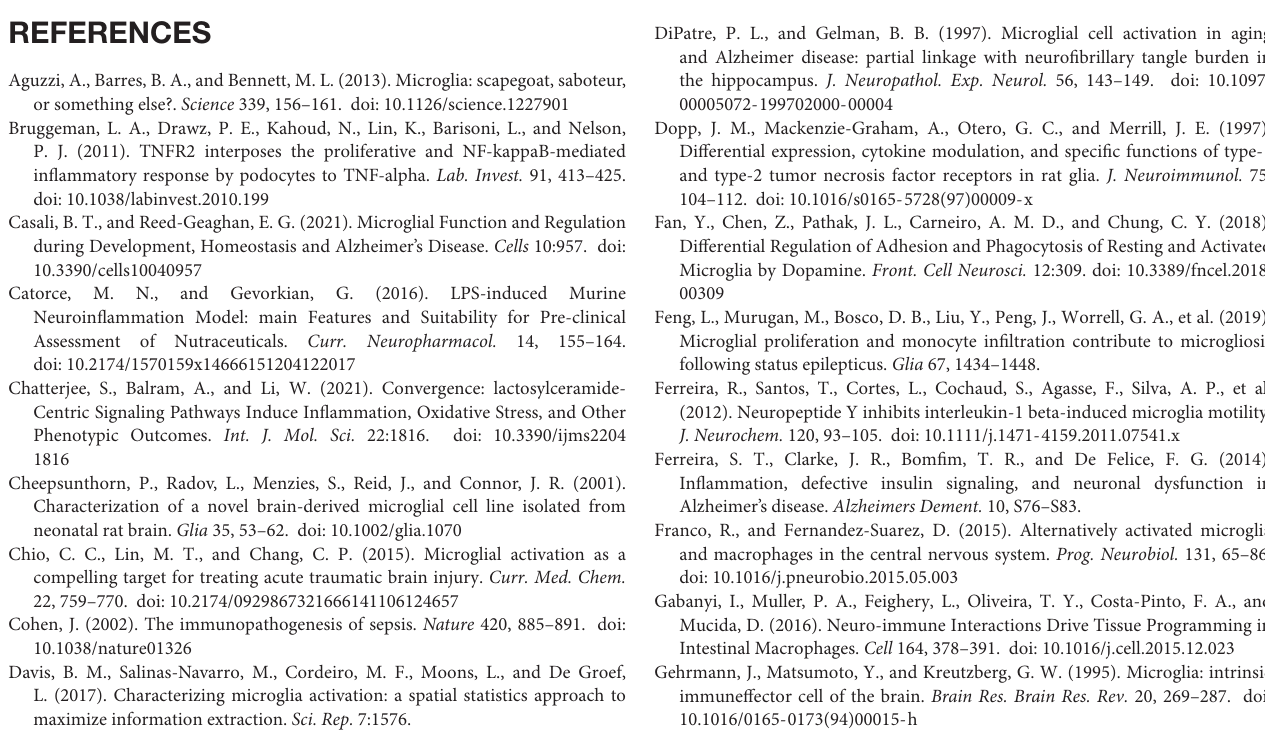
Supplementary Figure 1 | Expression of β -1,4-galactosyltransferase V ( β -1, 4-GalT V) in primary cultured microglia. Representative image for identification of microglia by Iba1 expression (A) ; scale bar, 50 µ m. Representative image for expression of β -1, 4-GalT V in primary cultured microglia cells (B) ; scale bar, 20 µ m. Supplementary Figure 2 | Efficiency of designated constructions in screened HAPI cells. Positive rates of designated EGFP-tag constructions as indicated (A,B) . (A) Representative image; scale bar, 50 µ m. (B) Quantification of positive rates in screened cells [(EGFP positive cells/Hoechst positive cells) × 100%] in panel (A) ; Validity of designated constructions in screened HAPI cells (C–F) . (C,E) Representative blots of β -1, 4-GalT V from screened HAPI cells as indicated. (D,F) Quantification of β -1, 4-GalT V for panels (C,E), respectively, and groups significantly different from the sham group were marked by an asterisk. No adjustments were made for multiple comparisons. The graph shows mean ± SD; n = 3; ∗ p < 0.05, ∗∗ p <